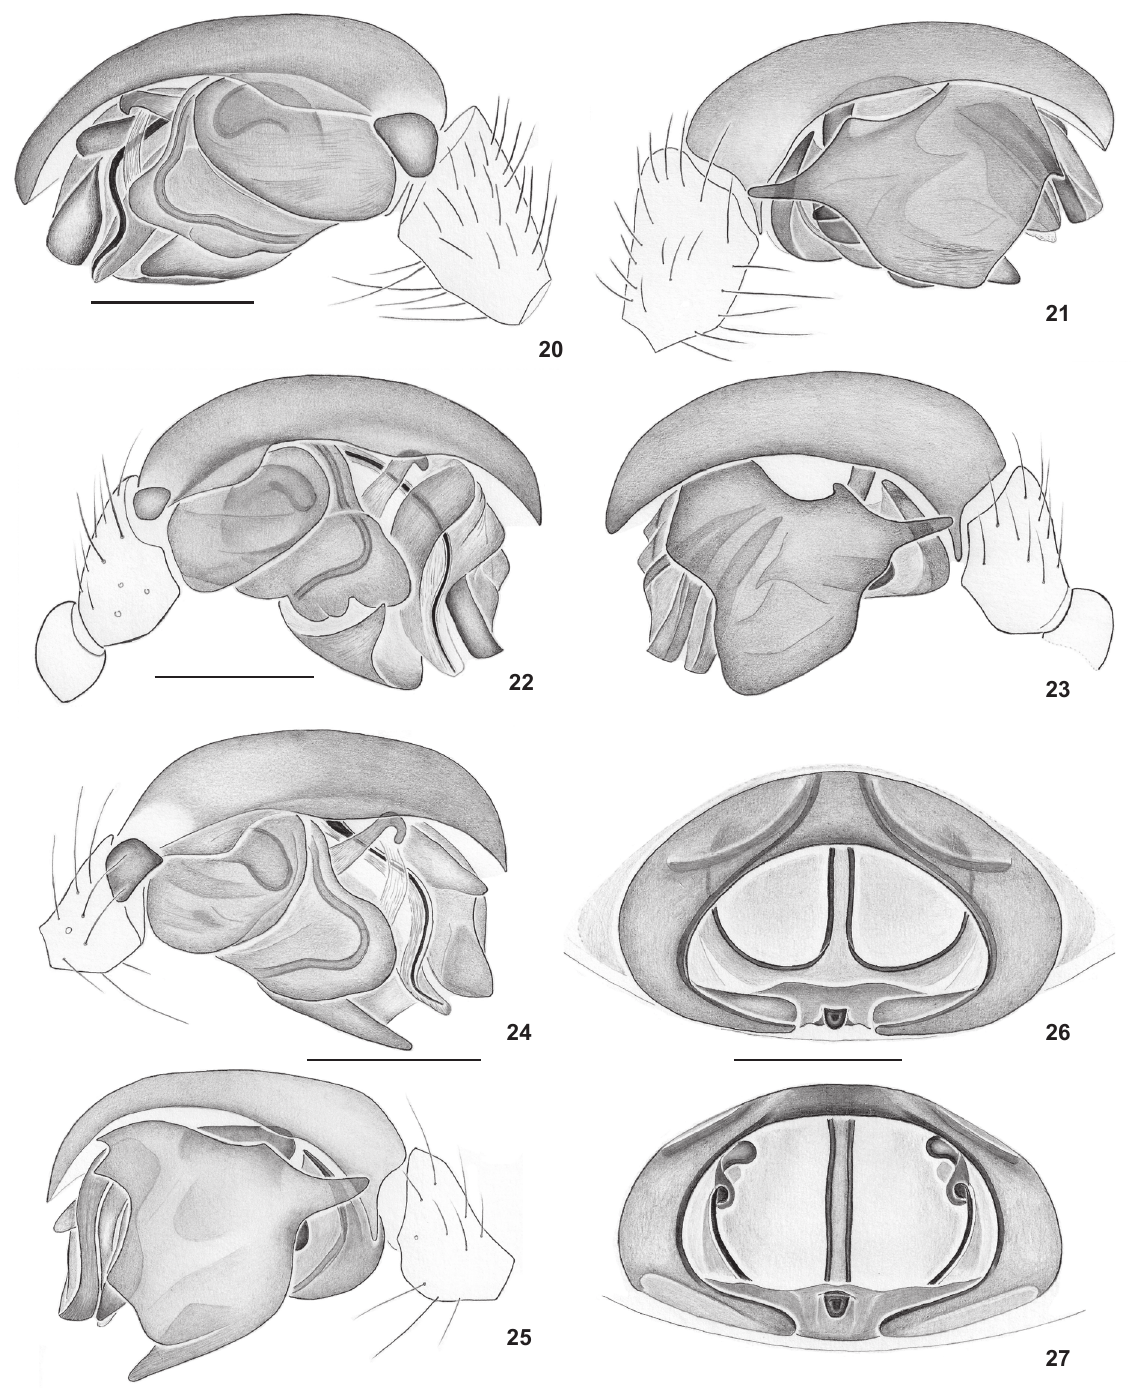
Figures 20-27. (20-21) Eurymorion mourai sp. nov. : (20-21) male palpus: (20) ectal view, (21) mesal view; (22-23) E. insigne : (22-23) male palpus: (22) ectal view, (23) mesal view; (24-27) E. nobile : (24-25) male palpus: (24) ectal view, (25) mesal view; (26-27) female epygine: (26) ventral view, (27) posterior view. Scale lines: 0,25